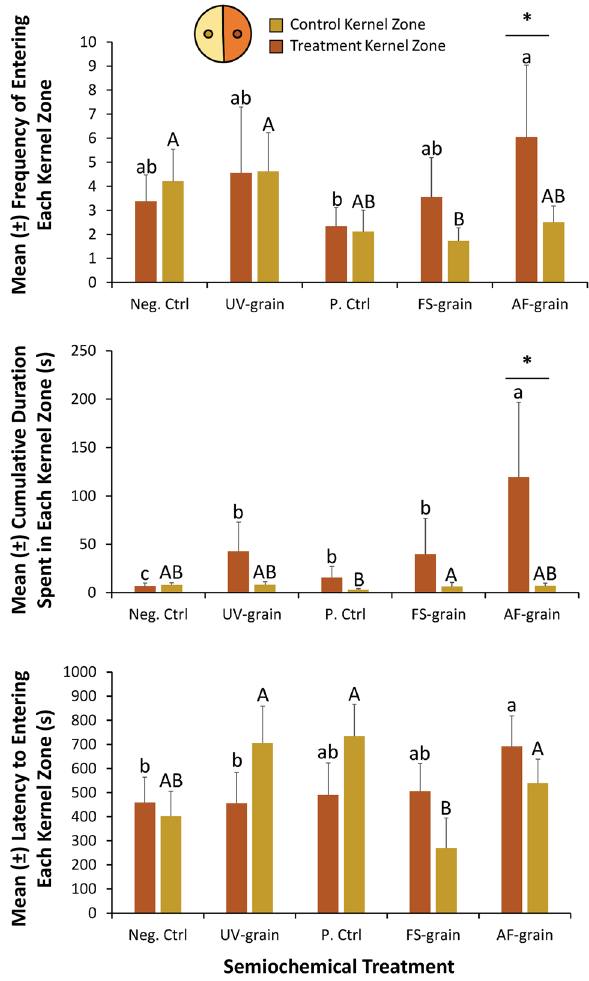
Figure 3. Treatment (dark orange bars) and control (dark yellow bars) kernel zone metrics from the movement assay, including determining how MVOCs affect the mean (± SE) frequency of entering each kernel zone (top panel), the cumulative duration spent in each kernel zone (middle panel), and the latency to finding and entering each kernel zone (bottom panel) by adult L. serricorne for a period of 30 min using video-tracking with a network camera coupled with Ethovision Software in the laboratory at the USDA-ARS Center for Grain and Animal Health Research in Manhattan, KS. The treatment kernel zone contains a single hard winter wheat kernel, while the control kernel zone does not contain any stimuli (neg. ctrl). There was a total of n = 20 replicate adults tested per treatment, translating to 50 h of data in this assay. Upper case letters represent multiple comparisons among levels of the control kernel zones only, while lower case letters represent multiple comparisons among levels of the treatment kernel zones only. Bars with shared letters are not significantly different from each other (Tukey HSD, α = 0.05). Asterisks (*) indicate post-hoc comparisons using paired t-tests (with Bonferroni correction), and only significant results have been displayed on applicable bars. Neg. Ctrl, negative control; UV-grain, UV-sanitized grain; P. Ctrl, uninoculated grain; FS-grain, F. verticillioides -inoculated grain; AF-grain, A. flavus -inoculated